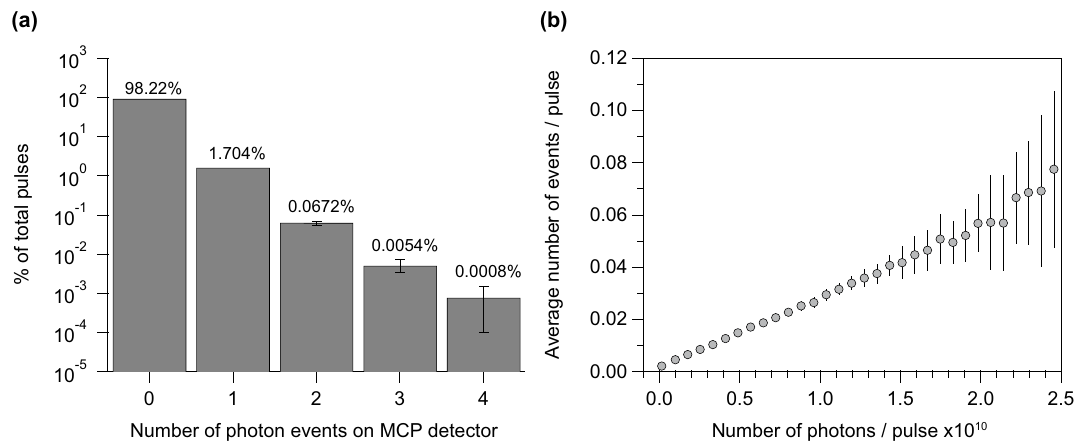
Figure 4. Pulse-by-pulse statistics analysis of RIXS measurements. ( a ) Distribution of the number of photon events on the Timepix detector. The majority of pulses created zero photon events on the detector. Error bars for 0 or 1 photon events are too small to plot. Events with more than 4 photons on the detector are excluded, as these originate from cosmic rays. ( b ) The average number of photon events on the Timepix detector per X-ray FEL pulse as a function of pulse intensity (in unit of number of photons). The linear relationship indicates that the measurement is in a weak-perturbation regime. The averages and the error bars were compiled from 37 scans, each of which consists of 25-minute of data (i.e . ~ 180,000 pulses) . The standard deviation is plotted as vertical bars associated with each data point. Some of the standard deviation bars are smaller than the marker size of data